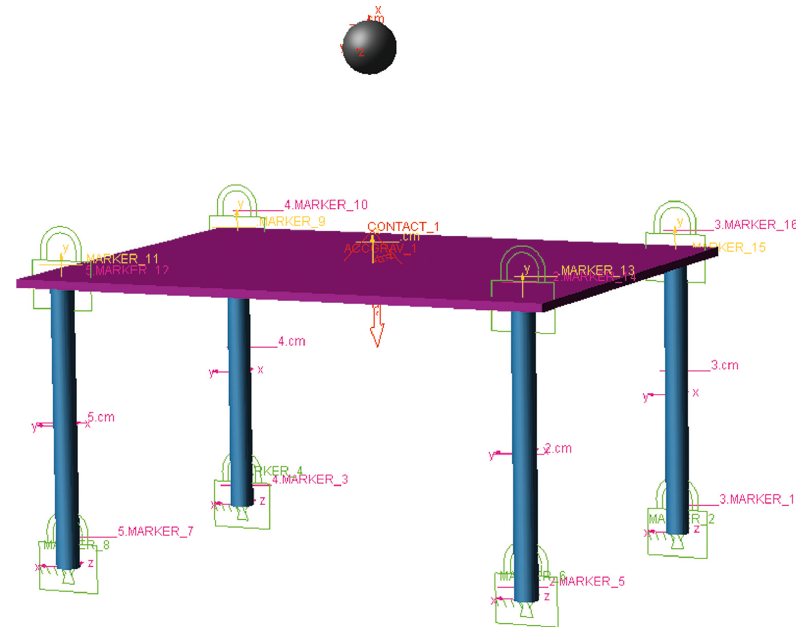
Figure 3: Rigid impact model.